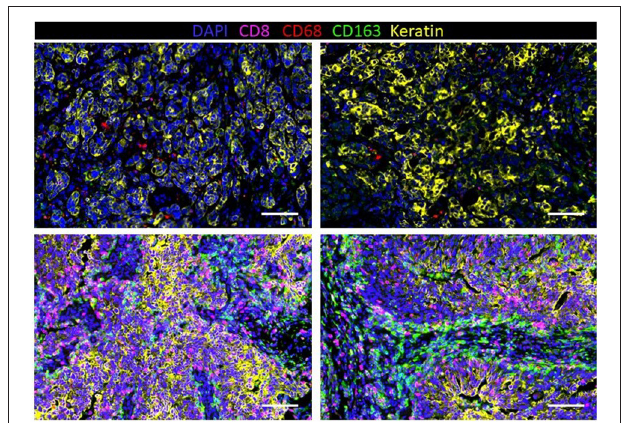
FIGURE 3 | Infiltration of macrophages (CD68 and CD163) and T cells (CD8) in human triple-negative breast cancer (TNBC) with a low density of immune cells (top row) and high density (bottom